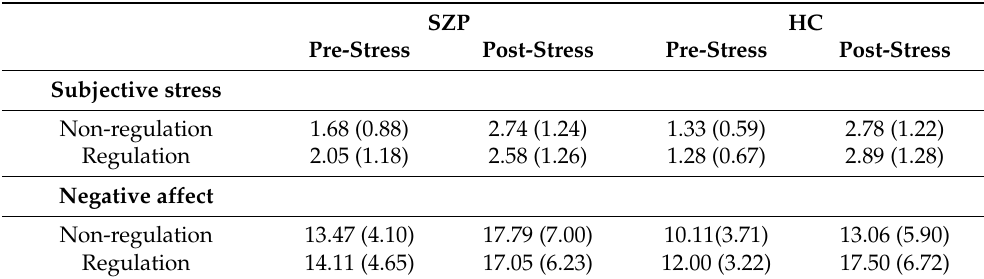
Table 2. Subjective